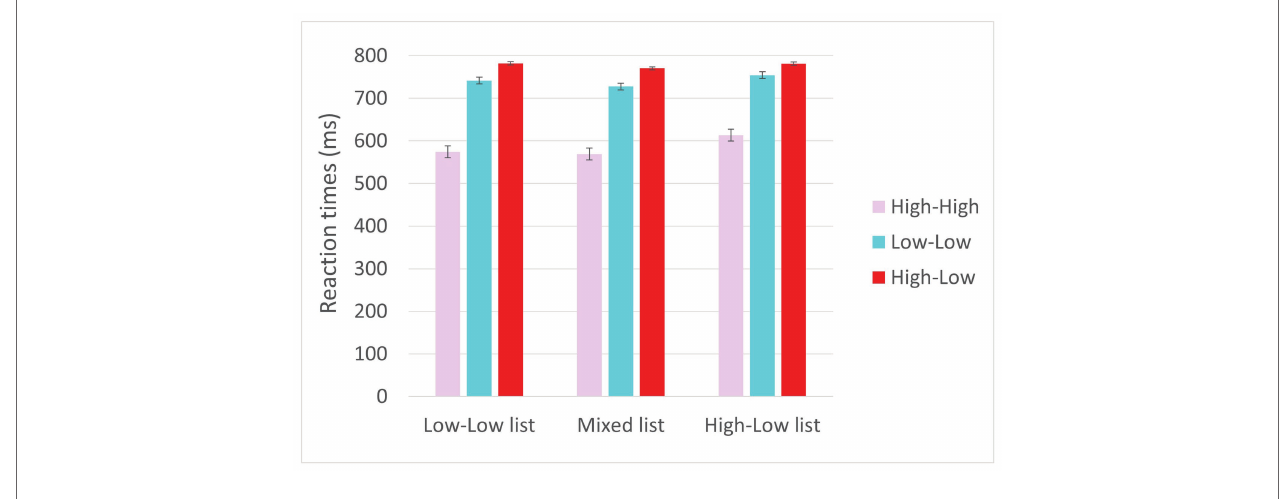
FIGURE 3 | Reaction times in the critical trials in Experiment 2.